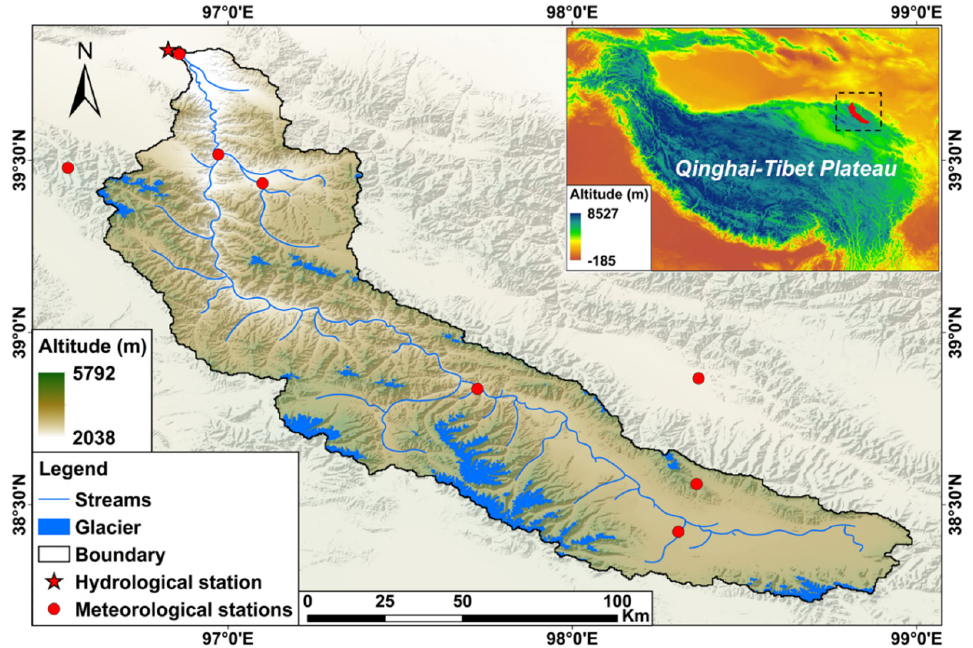
Figure 1. Overview of the Upper Shule River (USR) and the locations of hydrological and meteoro- logical stations.